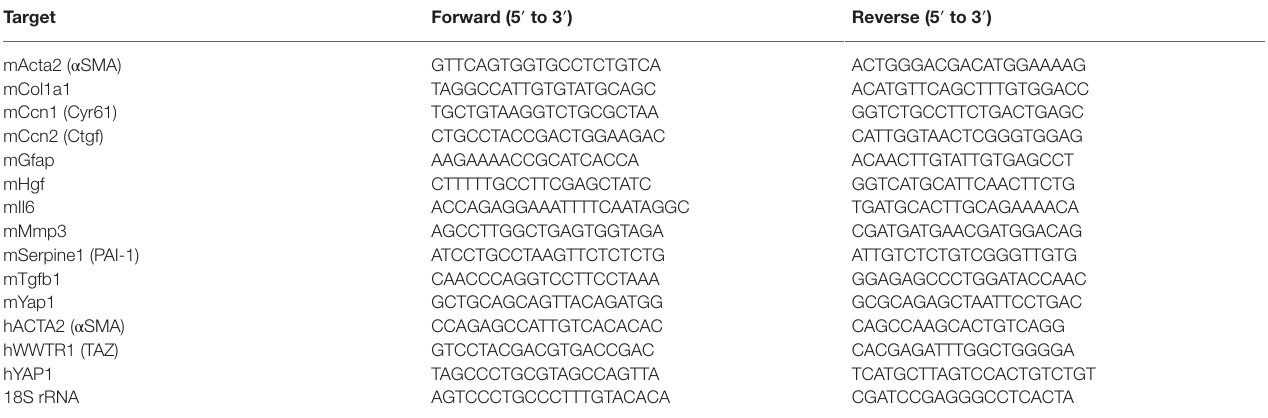
TABLE 1 | Primer sequences for